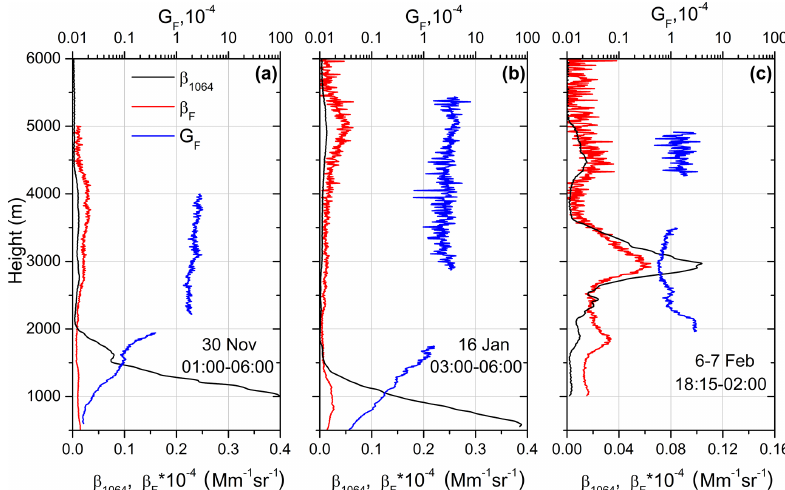
Figure 3. Vertical profiles of aerosol ( β 1064 ) and fluorescence ( β F ) backscattering coefficients together with the fluorescence capacity ( G F